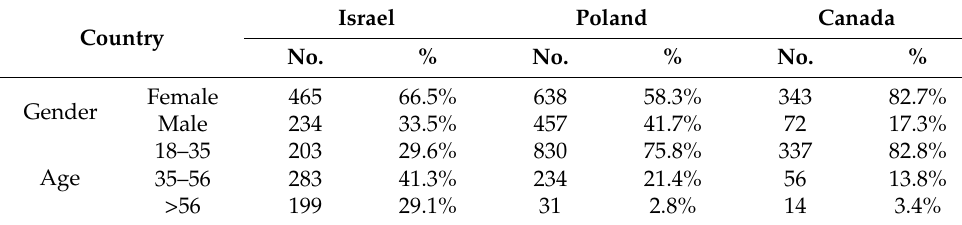
Table 1. Gender and age